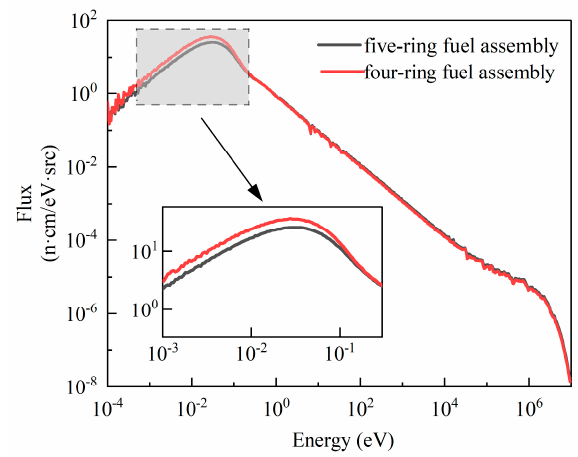
Figure 4. KLT − 40S fuel assembly neutron energy spectrum. Figure 4. KLT-40S fuel assembly neutron energy